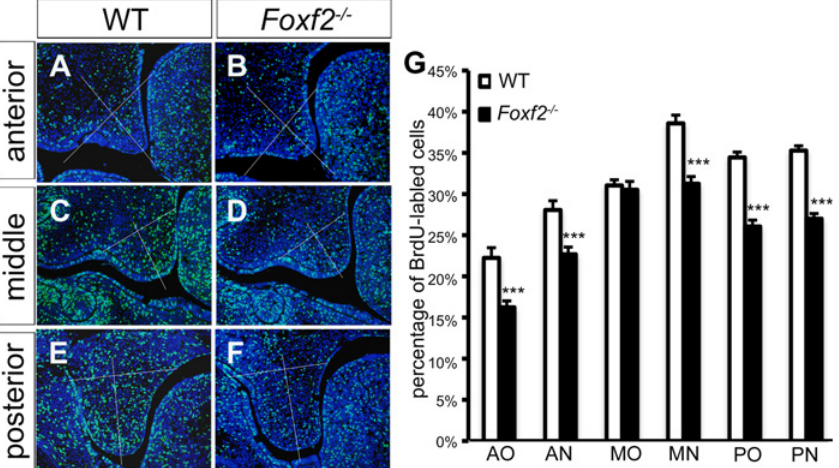
Fig 2. Analysis of cell proliferation in the developing palate in E13.5 Foxf2 -/- and wildtype embryos. (A-F) Representative images of sections through the anterior (A, B), middle (C, D) and posterior (E, F) regions of the palate in wildtype (A, C, E) and Foxf2 -/- mutant (B, D, F) embryos showing distribution of immunostained BrdU-labeled nuclei (green). Sections were counterstained with DAPI (blue). White line divides the palatal shelf into oral and nasal sides for cell counts. (G) The percentage of BrdU-labeled cells in the E13.5 palatal mesenchyme ( *** p < 0.001). AO, oral half of the anterior region; AN, nasal half of the anterior region; MO, Oral half of the middle region; MN, nasal half of the middle region; PO, oral half of the posterior region; PN, nasal half of the posterior